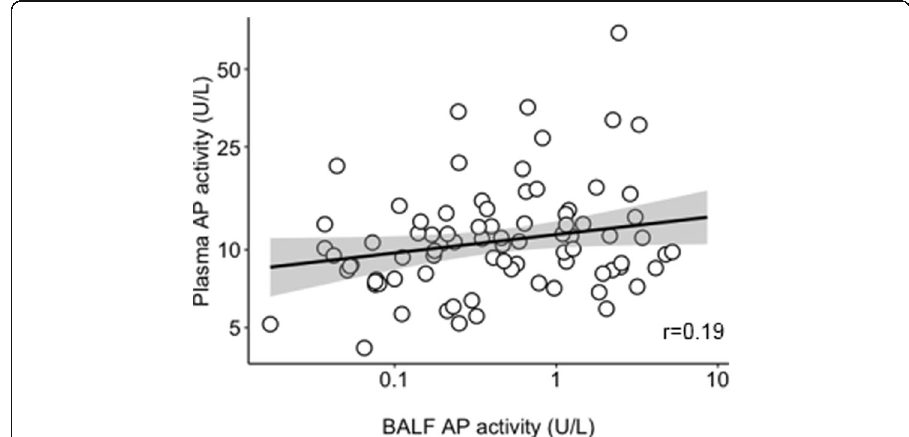
Fig. 4 Correlation between pulmonary and systemic AP activity in invasively ventilated critically ill patients.